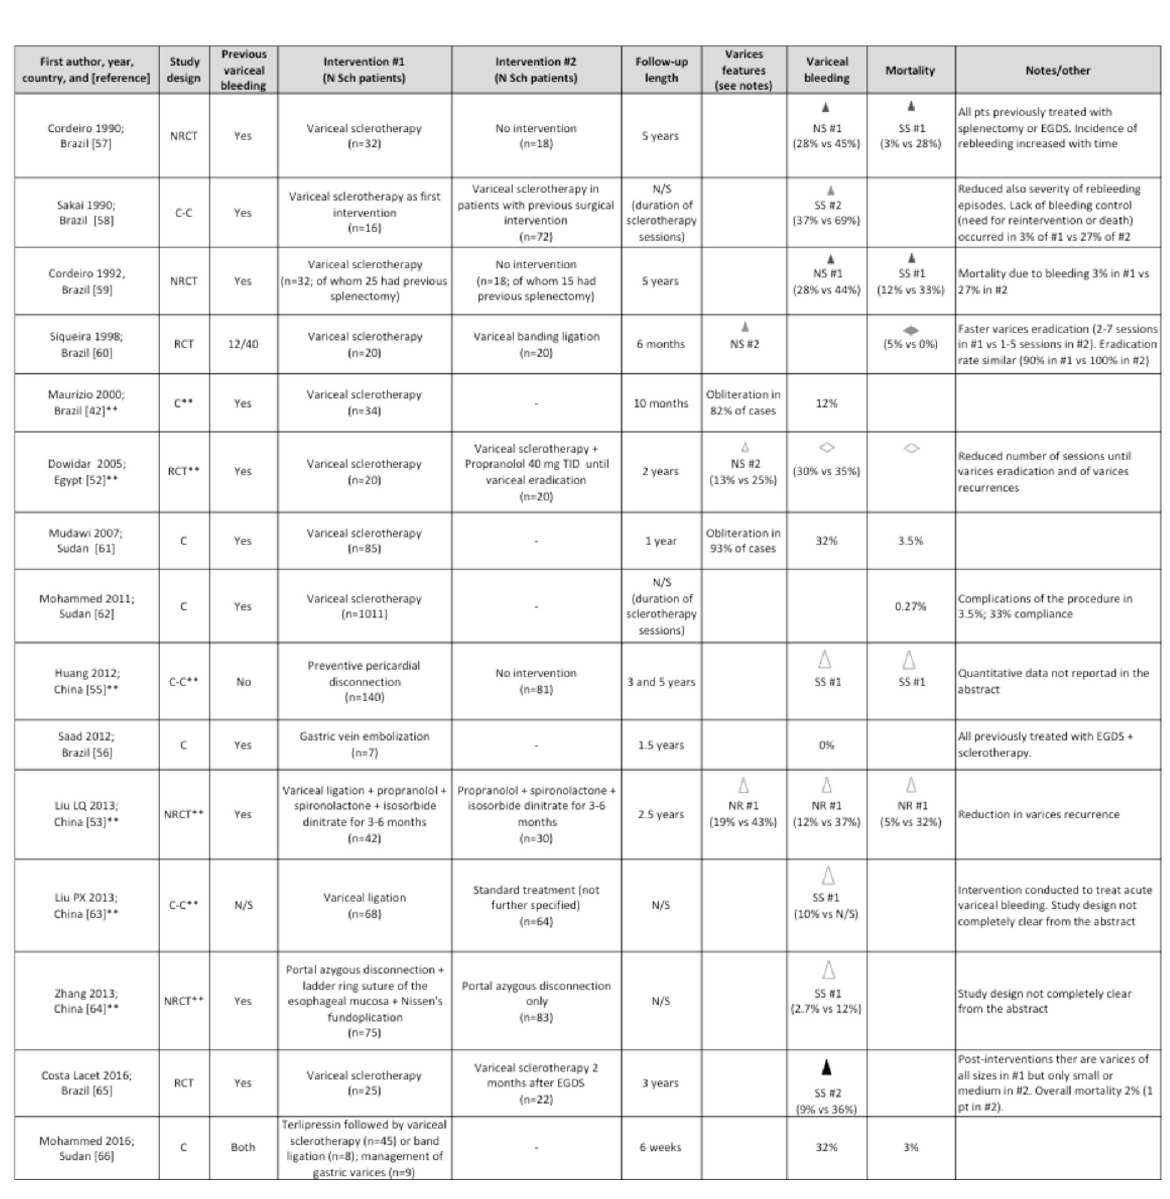
Fig 4. Direction effect chart summary of the included studies investigating the use of variceal management techniques for the clinical management of hepatosplenic schistosomiasis. Evaluation of all outcomes refers to the end of follow-up. �� Data extracted from abstract. § Study involving 1,073 patients, 93% of whom with schistosomiasis. EGDS, esophagogastric devascularization procedure with splenectomy; N/S, not specified; Sch, schistosomiasis. C, Cohort study. C–C, Case–Control study. RCT, Randomized Clinical Trial. NRCT, Non-Randomized Clinical Trial. UGB, upper gastrointestinal bleeding. Triangle orientation indicates direction of outcome: upward = amelioration in respect to other intervention or baseline, horizontal = no difference between interventions or from baseline. Triangle size indicates sample size per (smallest) group: small � 20 pts, medium 21–49 pts, large � 50 pts. Triangle color indicates quality of result based on study design and source: black = RCT, dark gray = NRCT, light gray = C–C, dotted = C, white = data from abstract. SS, statistically significant, NS, not statistically significant, NR, statistical analysis not reported. #n = intervention indicated in the corresponding “Intervention #n” column of the table to which the outcome direction refers [42,52,53,55–66]. procedure, including splenectomy, ligature of the left gastric vein, and devascularization of the great gastric curvature, without, however, finding significant differences in rebleeding rate between patients undergoing such technique followed or not by local variceal management sessions. Also, although not formally compared, the rebleeding rate after this variant